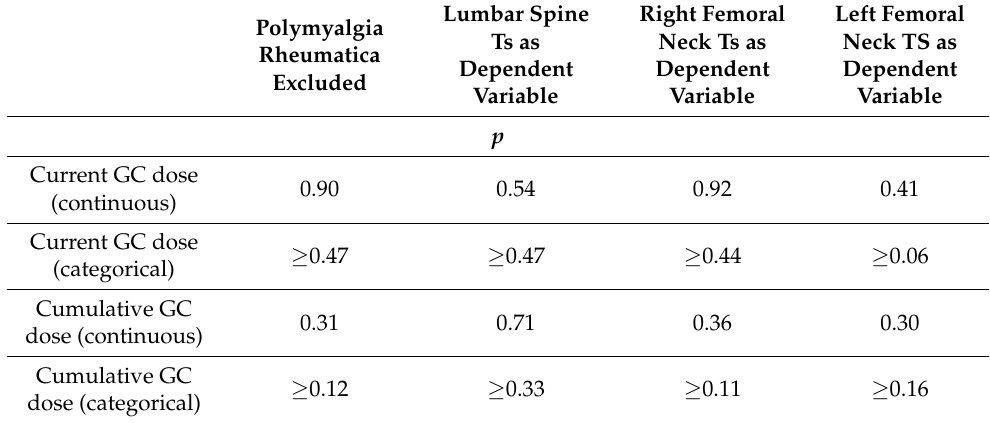
Table 5. Sensitivity